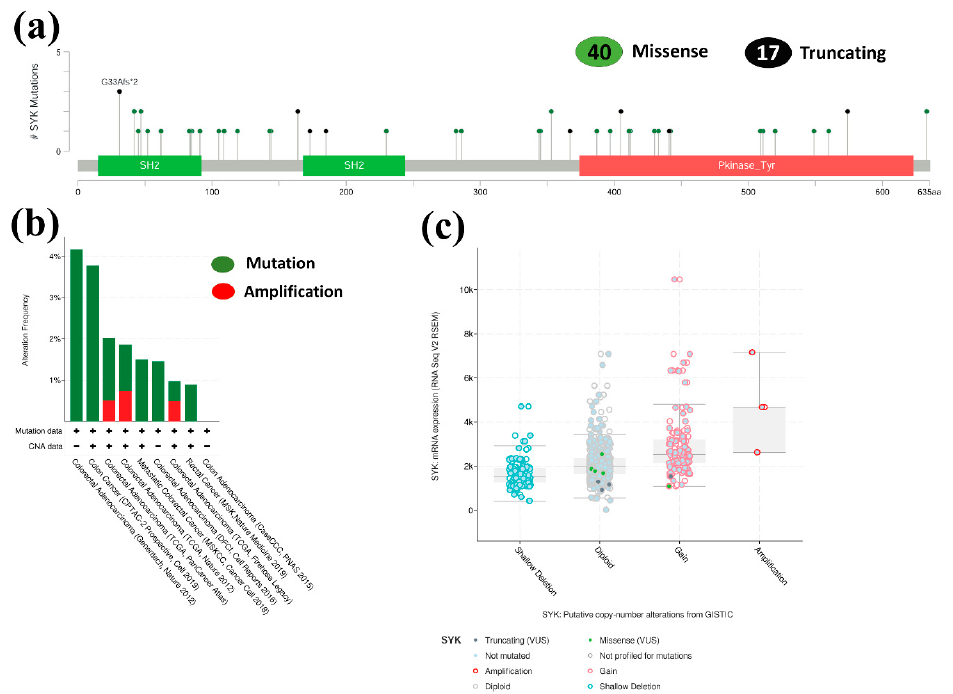
Figure 5. The graphical portrayal of the genetic alteration in the SYK protein sequences based on CRC growth improvement. ( a ) In total, 57 mutations were pointed out in the SYK protein sequence using a lollipop plot. ( b ) Two sorts of alteration frequencies of SYK across different CRC studies were introduced in a bar outline. ( c ) The mRNA expression level of SYK in regard to the different classifications of genetic alterations was addressed in graphical plots dependent on the RNA seq V2 RSEM scale.